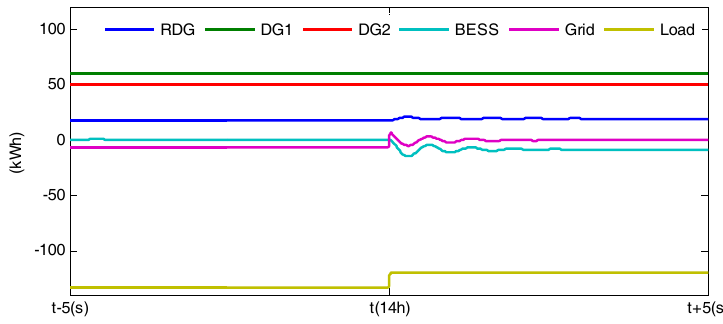
Figure 13. The response of all components when the MG switches to the islanded mode at 14 h.